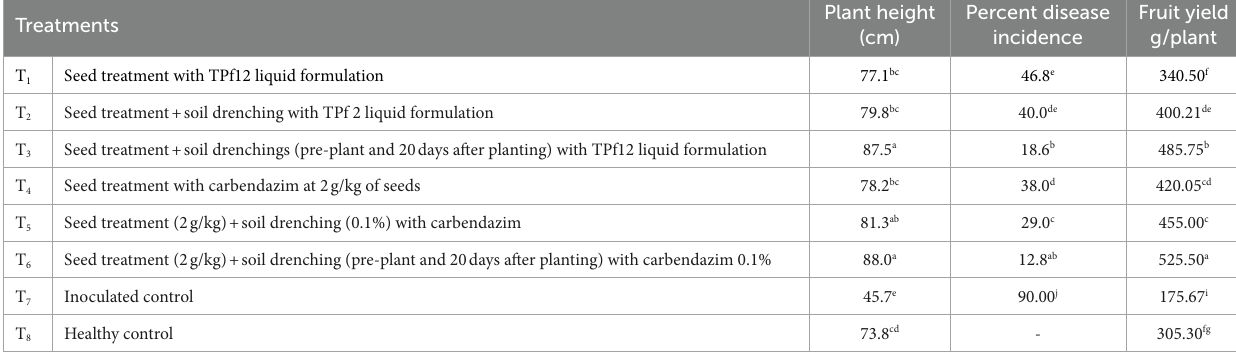
Plant height Percent disease Fruit yield (cm) incidence g/plant